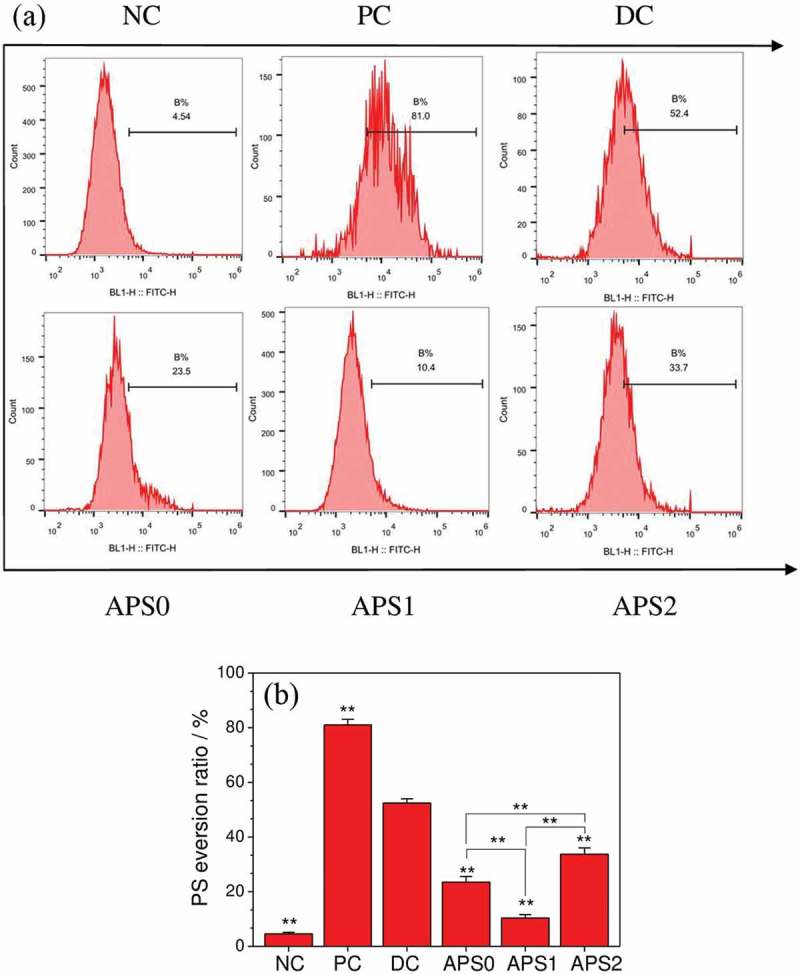
Quantitative detection of PS eversion of damaged HK-2 after APS repair by flow cytometry. (a) Histogram of PS eversion ratio; (b) statistical histogram of the percentage of PS eversion. NC: normal control, PC: positive control (CCCP); DC: damaged control; polysaccharide concentration: 60 μg/mL; oxalate damage concentration: 2.6 mmol/L; damage time: 3.5 h; repair time: 10 h. Compared with DC group, **P < 0.01.